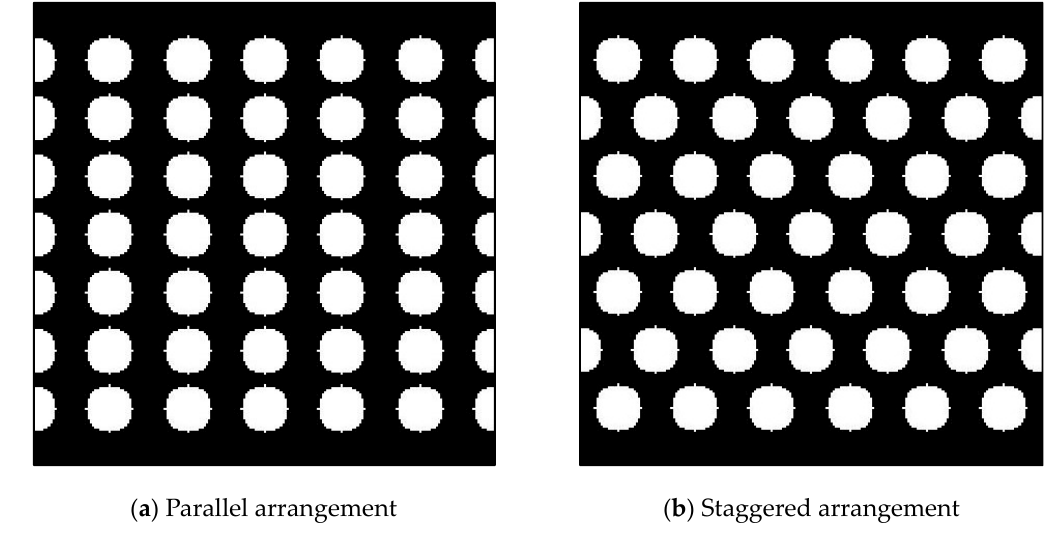
Figure 15. Parallel arrangement structure and staggered arrangement structure.